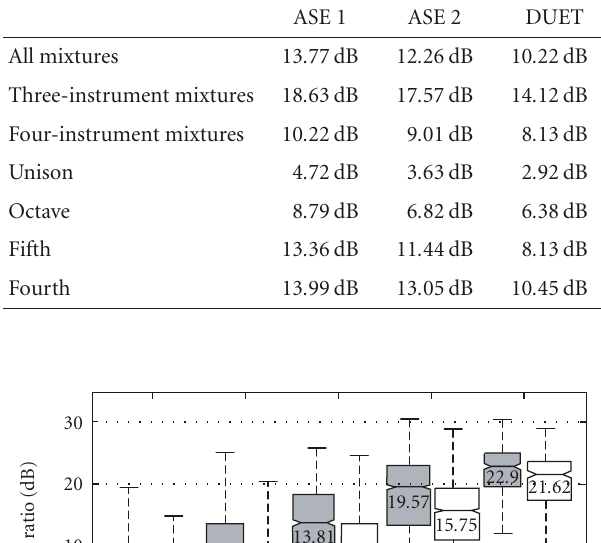
algorithm, using a window length of 46 milliseconds and step size of 6 milliseconds for STFT processing.